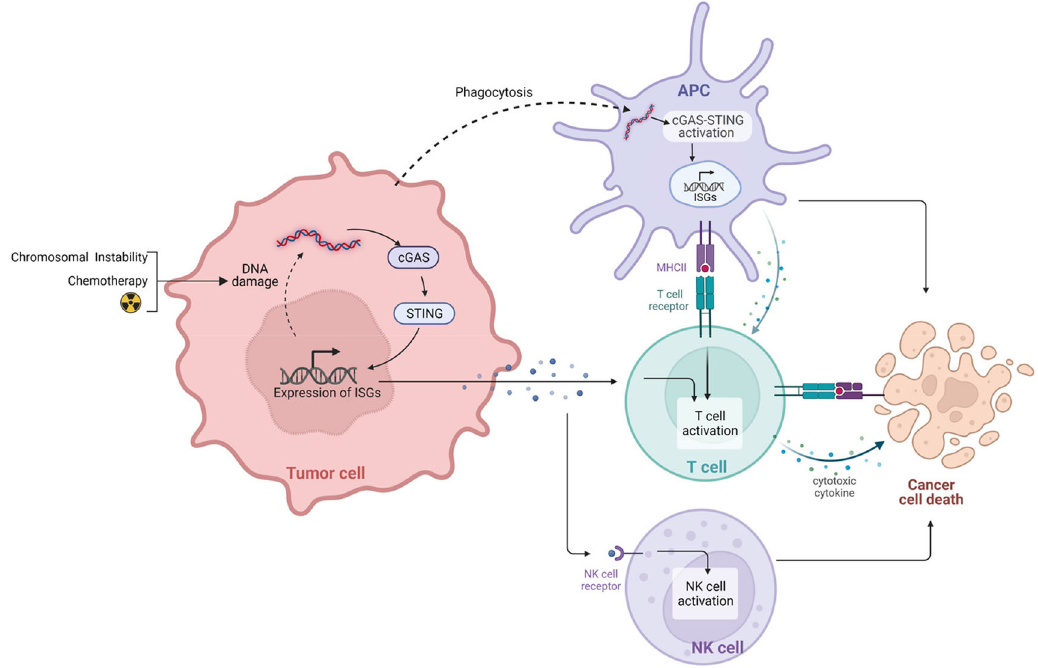
Figure 1. cGAS-STING activation in dying tumor cells and APCs. STING activation in antigen presenting cells (APC) occurs upon phagocytosis of tumor cells. In the phagosome, MHC loading occurs and there is subsequent activation of T cells through T-cell Receptor (TCR) signaling. Degradation of tumor cells leads to the accumulation of cytoplasmic double-stranded DNA (dsDNA). dsDNA activates cGAS triggering the conversion of ATP and GTP into cyclic GMP-AMP (cGAMP), a second messenger. cGAMP activates STING which translocates to nuclear compart- ment triggering transcription of interferon stimulating genes (ISGs) and production of type I IFNs and proinflam- matory cytokines through phosphorylation of IRF3 and NF-kB transcription factors. Similarly, within tumor cells, cDNA accumulation occurs due to DNA damage from chromosome instability or treatment leading to cGAS-STING pathway activation. Production of type I IFNs triggers the membrane translocation of retinoic acid early transcript 1 (RAE1), a NKG2D ligand which interacts with NK Cells resulting in their activation. Created with